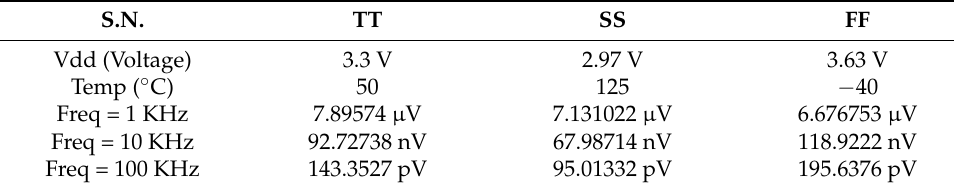
Table 3. Summary of the operational amplifier noise analyses.